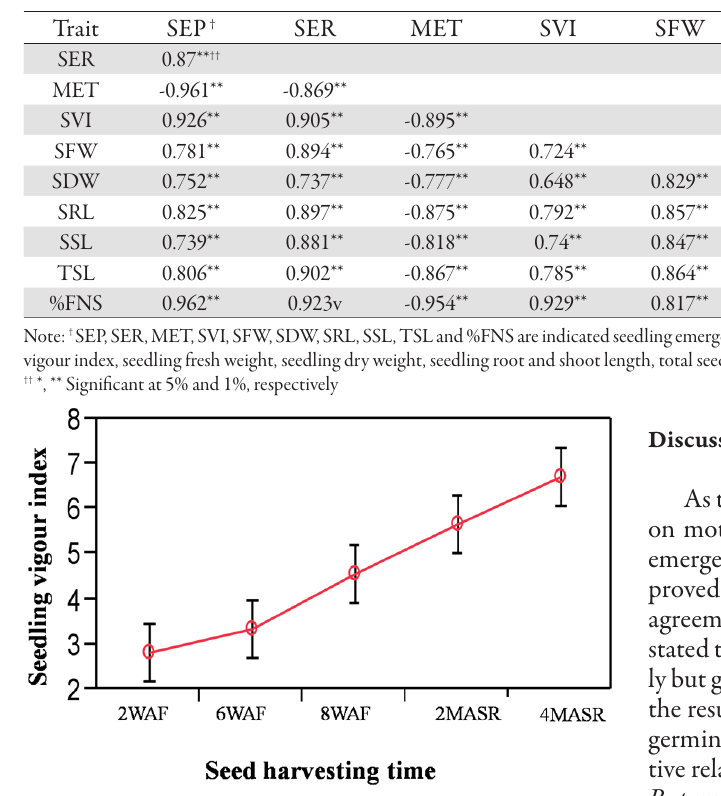
Tab. 3. Pearson correlation coefficients (n=20) seedling vigour traits of R. turcomanicus Czerep collected in different